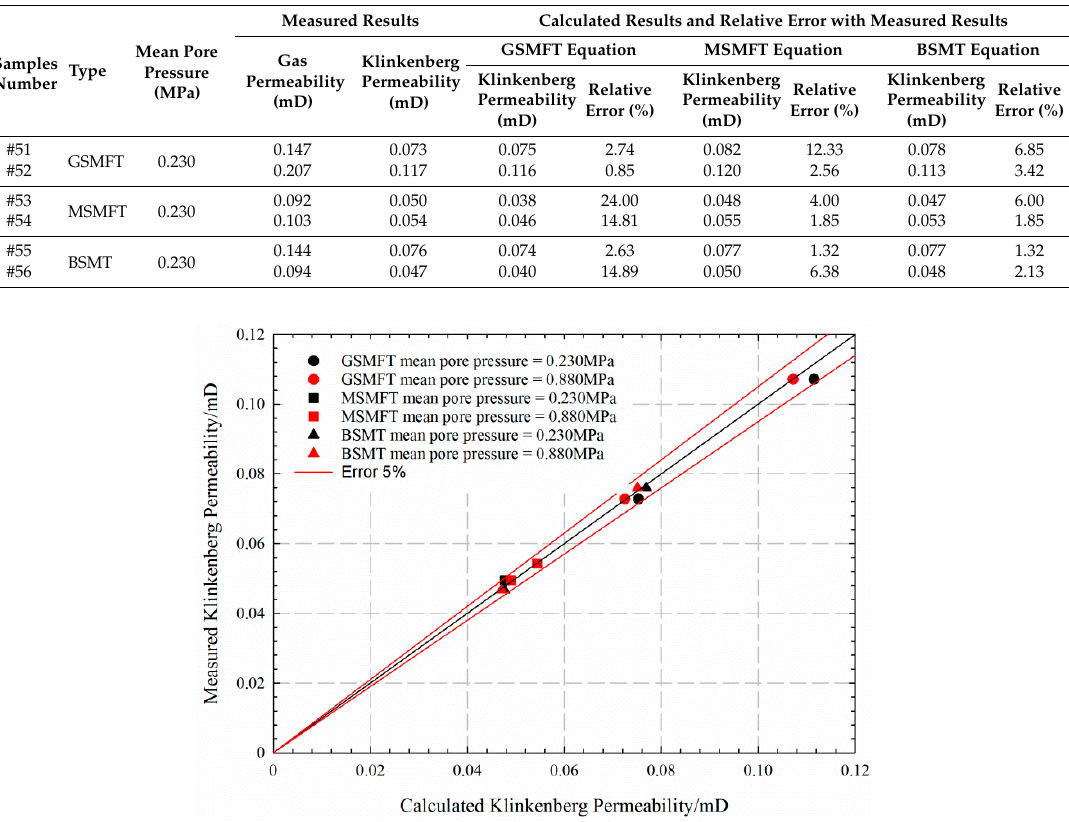
Table 4. The measurements and calculated results of Klinkenberg permeability.